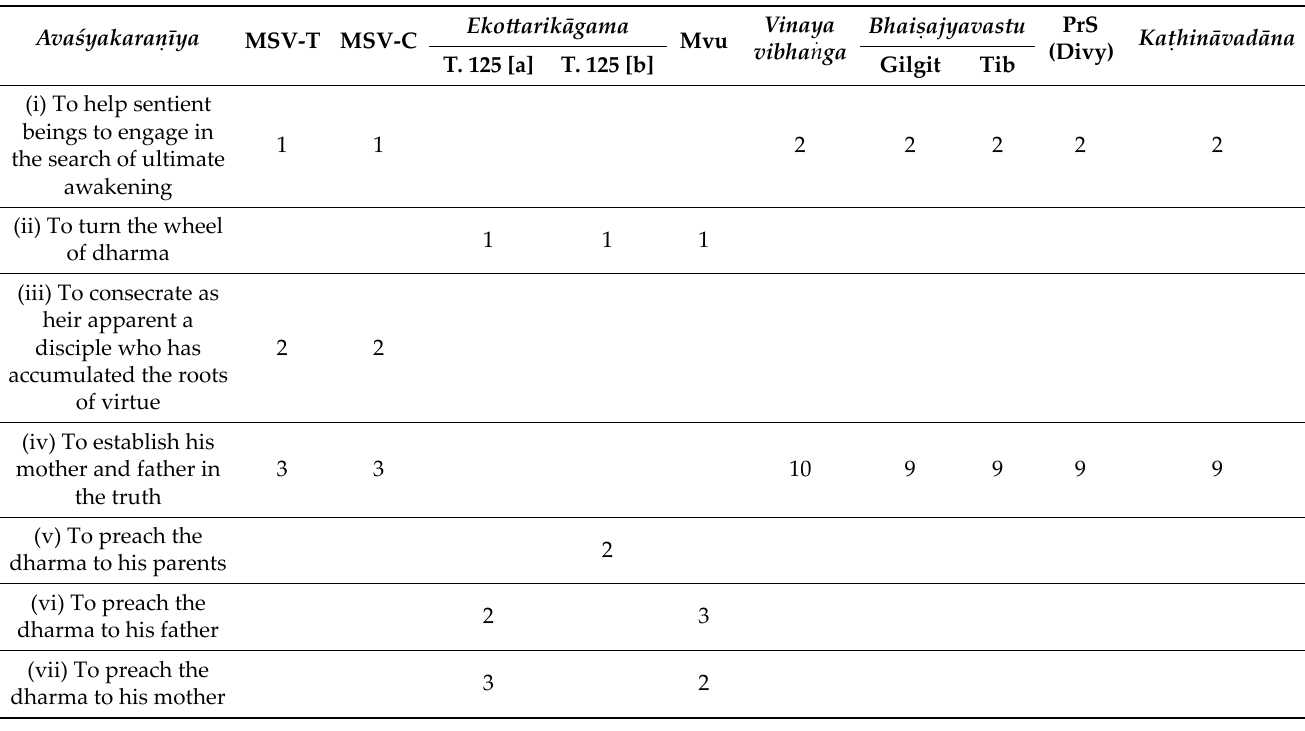
Table 1. List of necessary deeds of a Buddha in various Buddhist